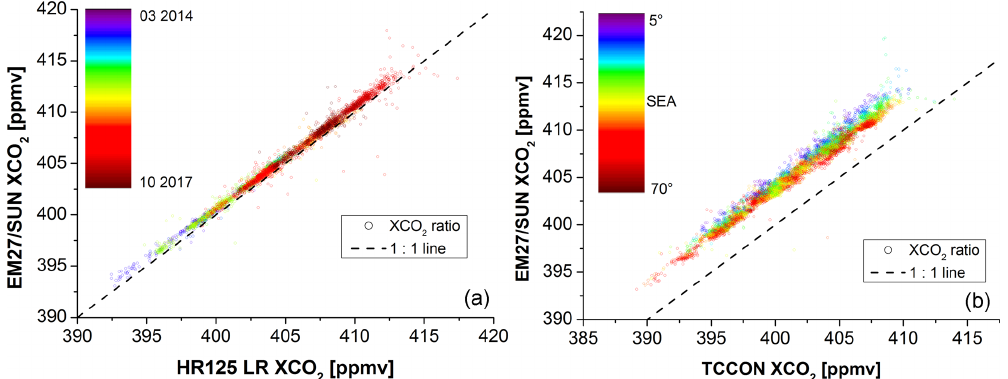
Figure 5. (a) shows the XCO 2 comparison between EM27/SUN and HR125 LR. The colorbar denotes the date of the measurement; the dashed line is the 1 : 1 line. In (b) the comparison with TCCON is shown. Note that here the colorbar shows the solar elevation angle.